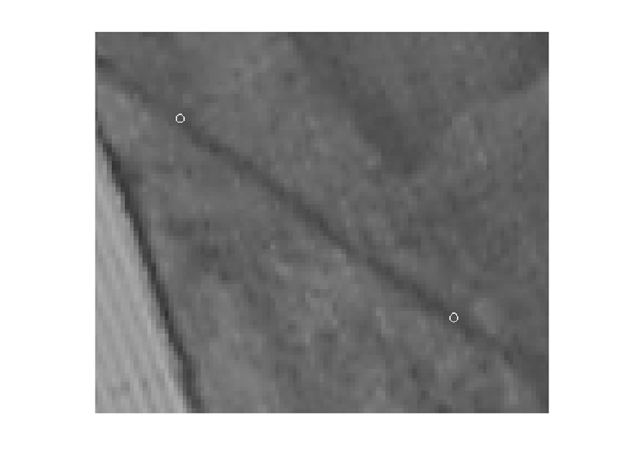
Figure 1. Archaeological traces in the area of Foggia (Italy).